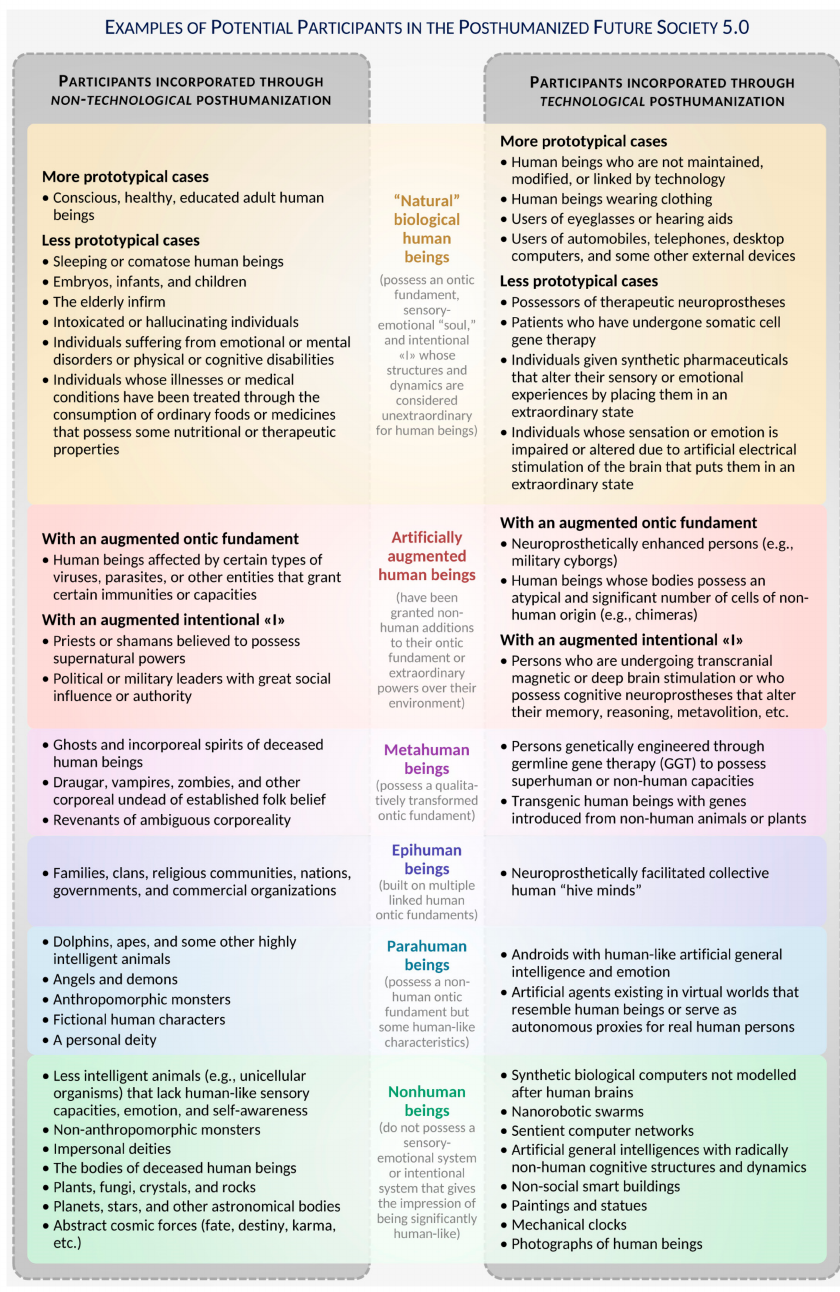
Figure 3. The technologically posthumanized Society 5.0 is expected to incorporate six categories of participants whose analogues existed in earlier non-technologically posthumanized